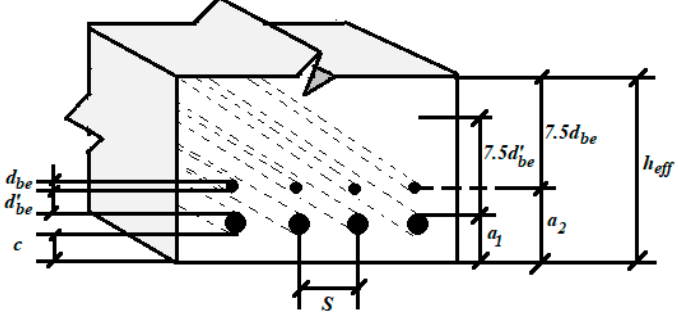
Figure 1. Thickness of the buried area according to CSA-S474-2044 [53].